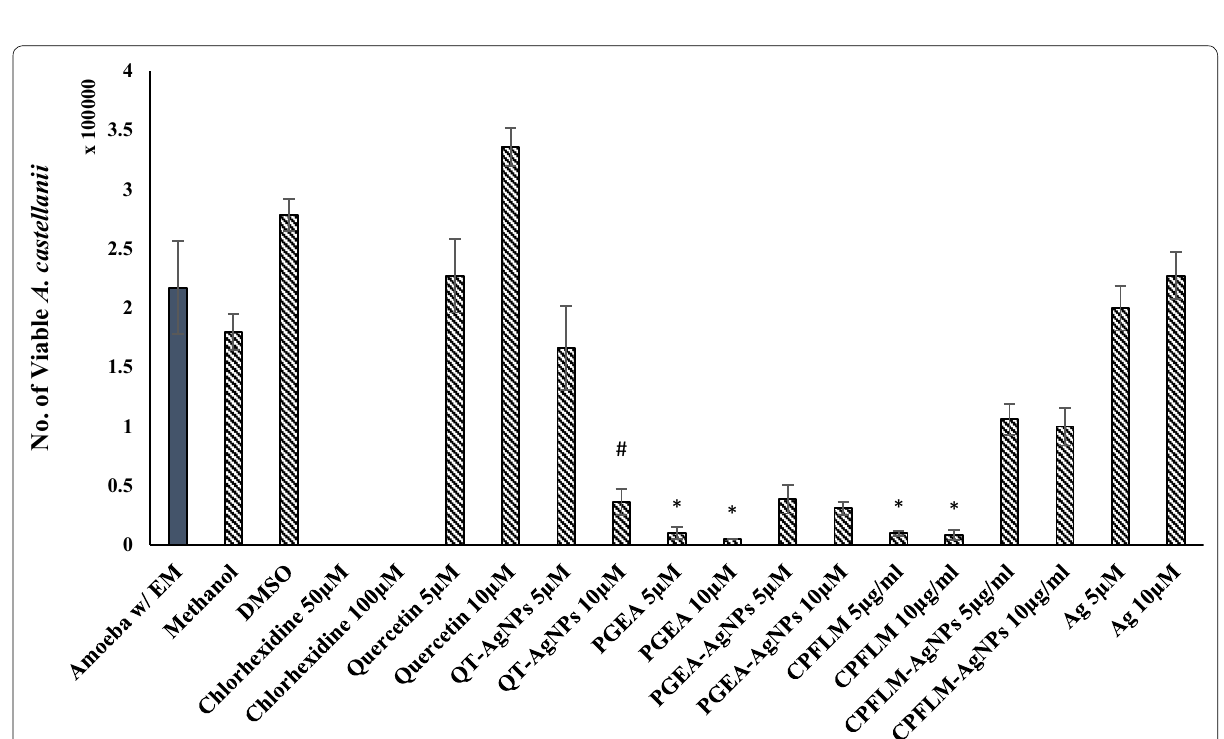
Fig. 5 Effects of QT, PGEA, CPFLM and the nanoconjugates of the natural compounds above mentioned on the encystation of A. castellanii . 5 amoebae were incubated with encystation media (E.M, including 10% glucose and 5 μM MgCl 2 ) and respective 5 and 10 μM of compounds or nanoconjugates for 72 h at 30 ° C. Then the cysts were counted after adding 0.05% of Sodium dodecyl sulfate (SDS). 10 μM of QT-AgNPs showed significantly enhanced encystation activity as compared to QT and AgNPs alone (#P < 0.05, using two sample T-test, two-tailed distribution). PGEA and CPFLM alone showed significant inhibition of A. castellanii encystation when compared to the negative control (amoeba two sample T-test, two-tailed